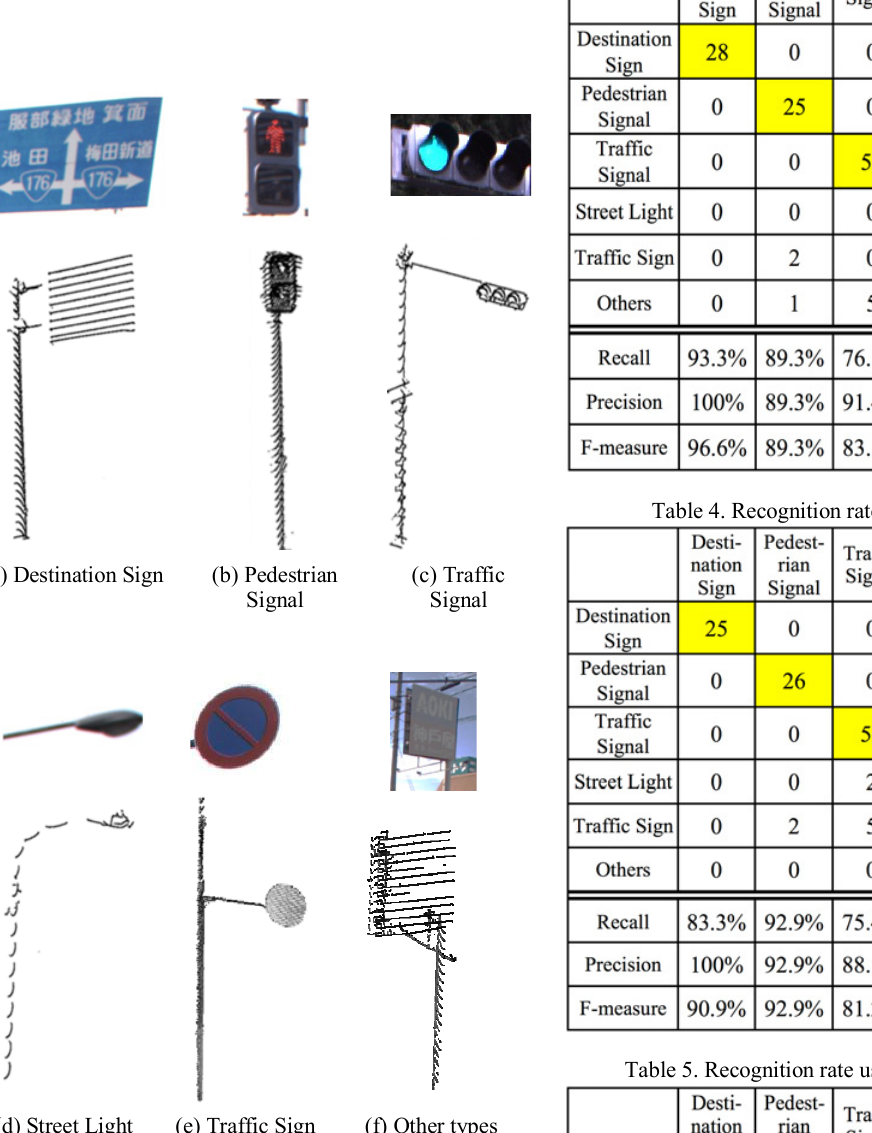
Figure 13. Type of pole-like objects